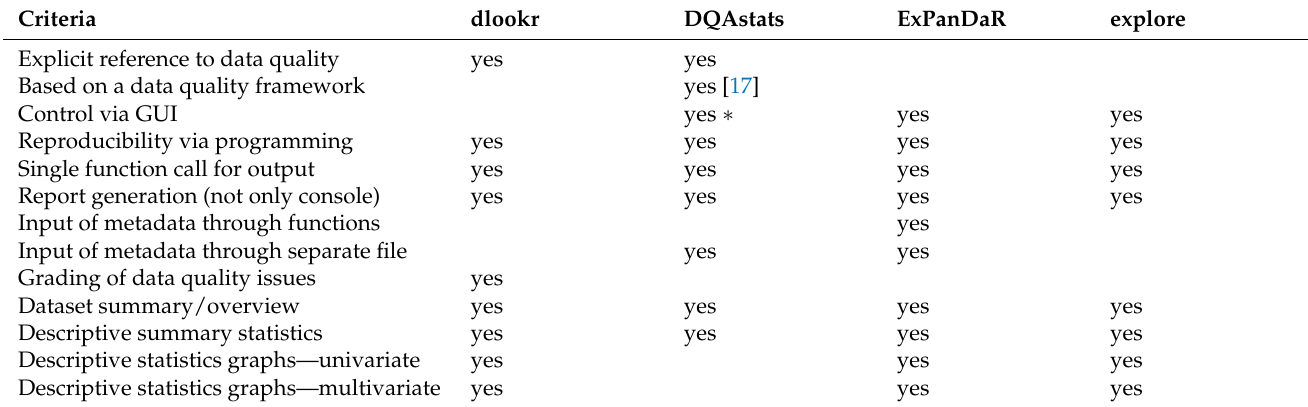
Table A3. Data quality assessment capabilities by package